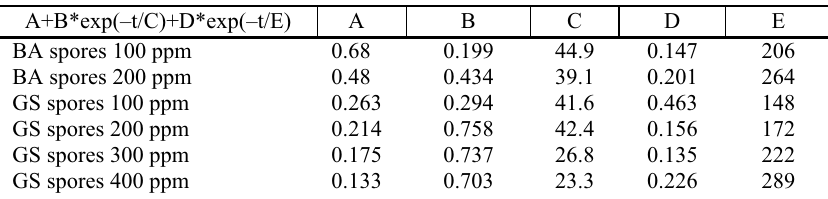
Table 2. Biexponential fitting parameters for Trp-like fluorescence peak intensity change during HPV decontamination of BA and GS